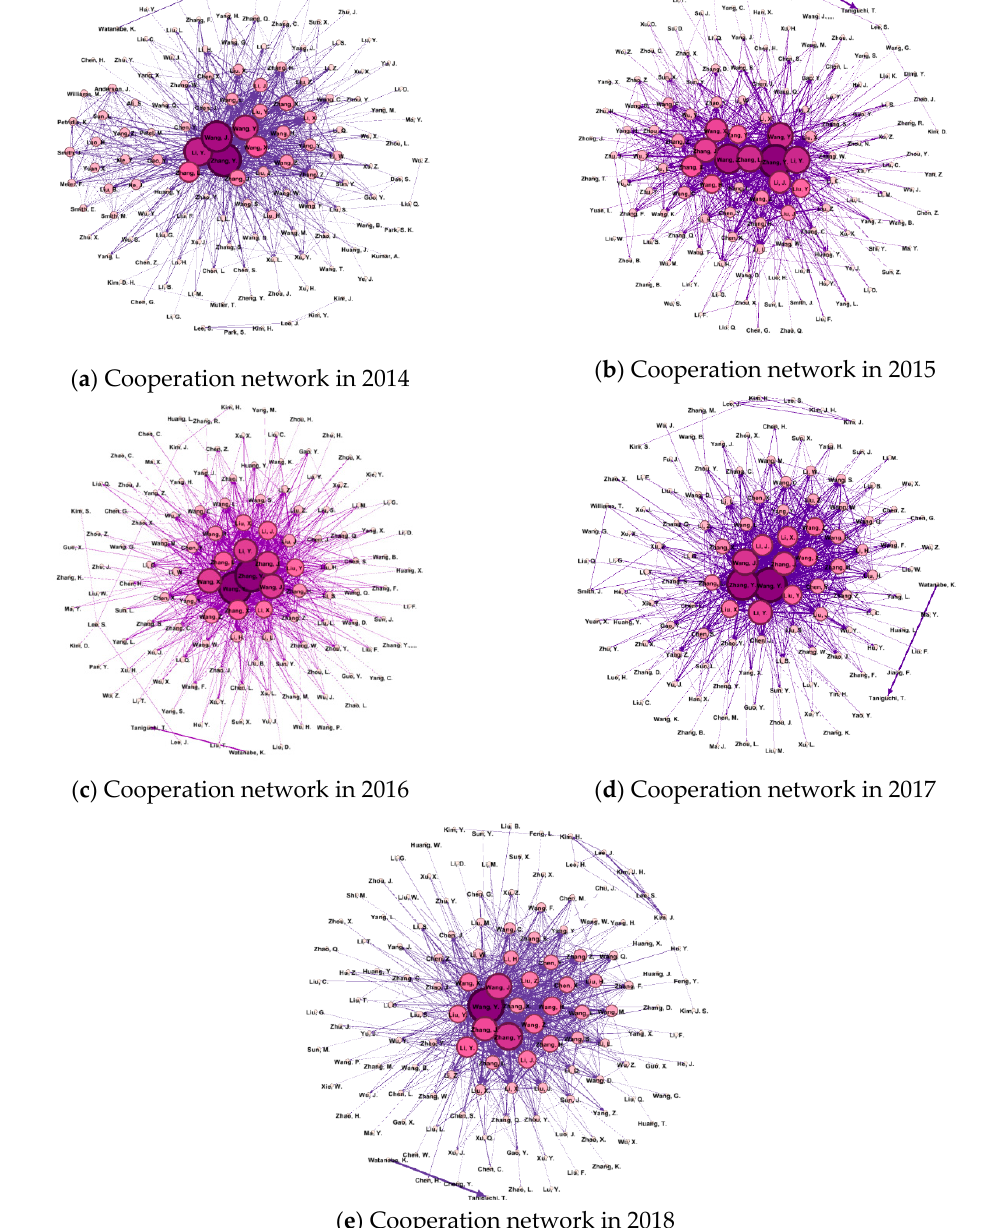
Figure 2. Cooperation network graphs among authors during 2014–2018. Figure 2 contains five graphs, which are arranged by year as: ( a ) 2014, ( b ) 2015, ( c ) 2016, ( d ) 2017, ( e ) 2018.